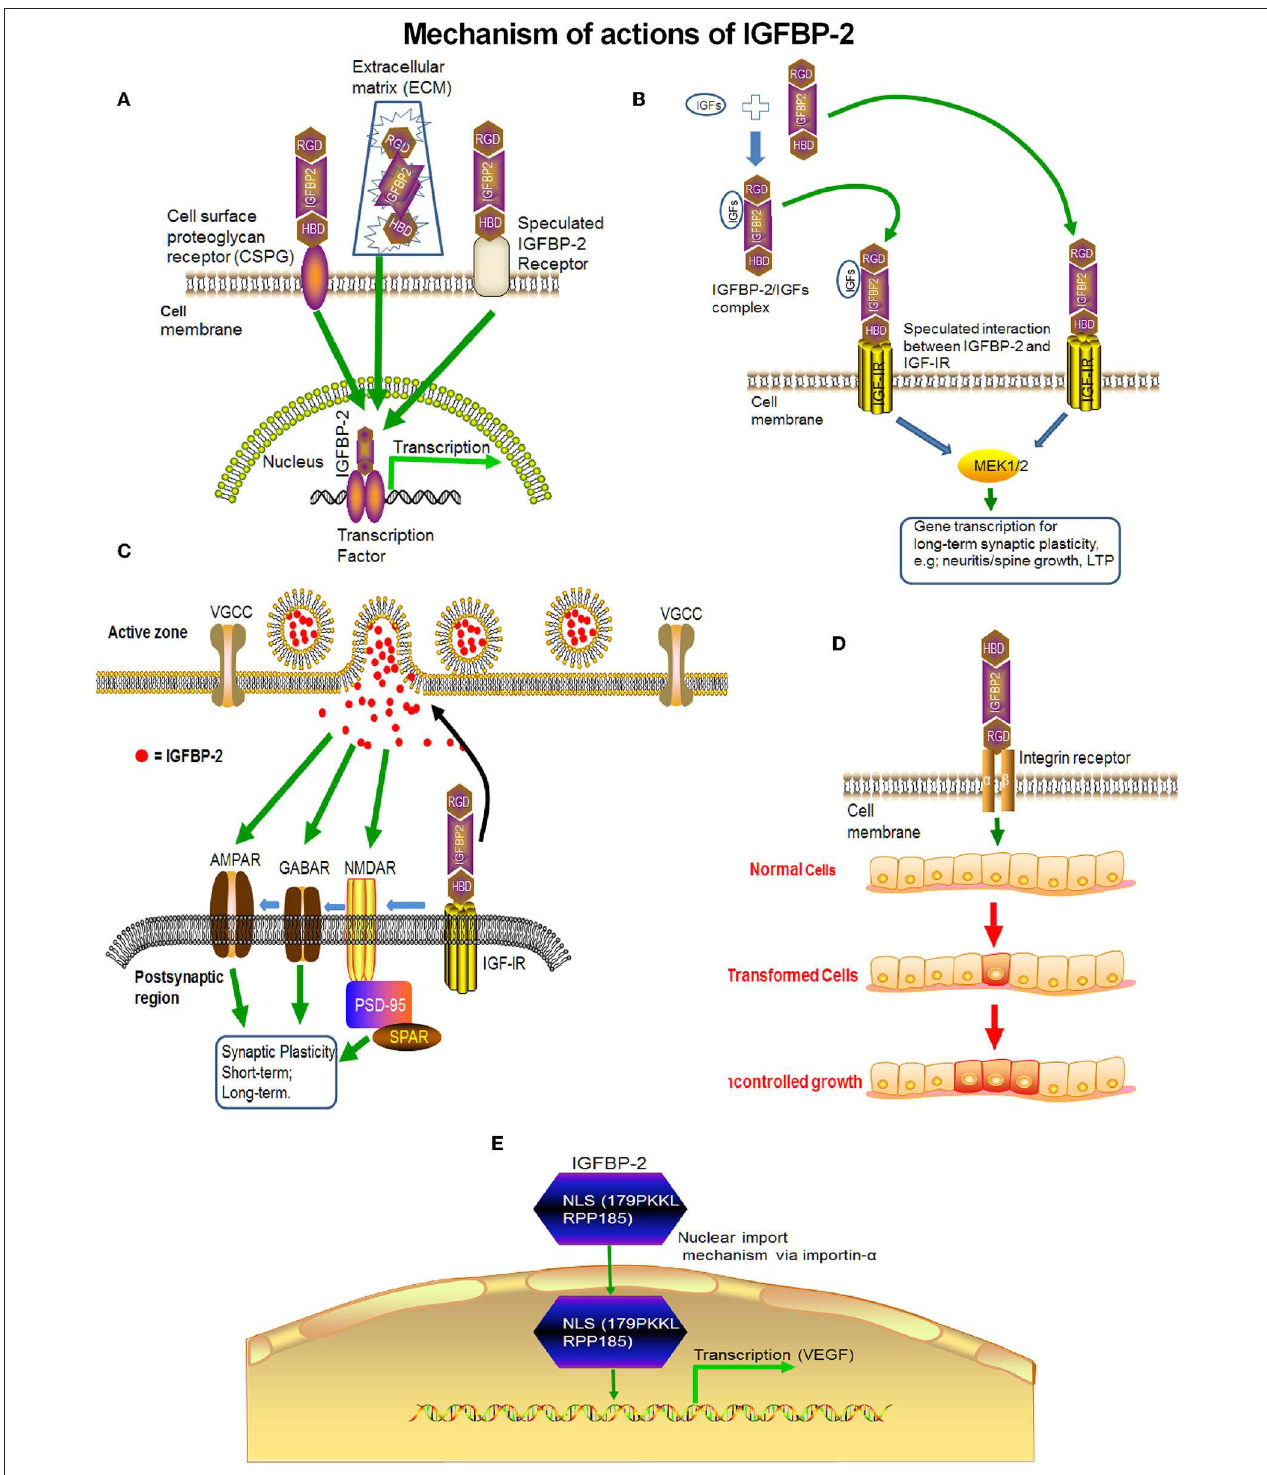
FIGURE 5 | The probable mechanisms of action of IGFBP-2 in the CNS. (A) IGFBP-2 may directly bind with putative IGFBP-2 receptors on the neural membrane and may initiate transcription. (B) IGFBP-2 may bind with IGF-IR via the HBD domain and may initiate downstream signaling via the ERK1/2-MAPK pathway. (C) After binding with IGF-IR via the HBD domain, IGFBP-2 may transfer the signal to AMPAR, GABAR, or NMDAR to modulate neurotransmission for short term synaptic plasticity. (D) IGFBP-2 binds with integrin receptors via the RDG-domain and initiates malignancy. (E) IGFBP-2 may directly cross the cell membrane via nuclear localization signaling and initiate